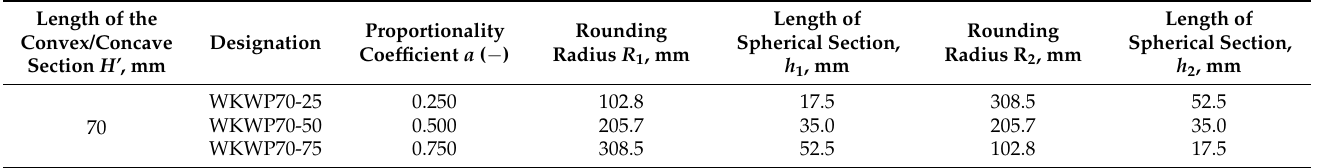
Table 3. Geometric parameters of WKWP dies.